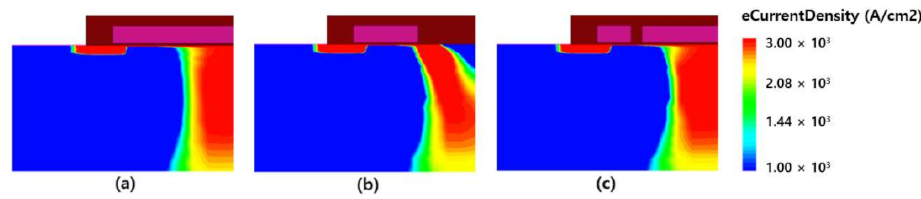
Figure 8. Electron current density of ( a ) C-DMOSFET (conventional planar DMOSFET); ( b ) SG- DMOSFET (split-gate DMOSFET); and ( c ) FPS-DMOSFET (floating p+ polysilicon DMOSFET) in the on state ( V GS = 20 V, V DS = 20 V).